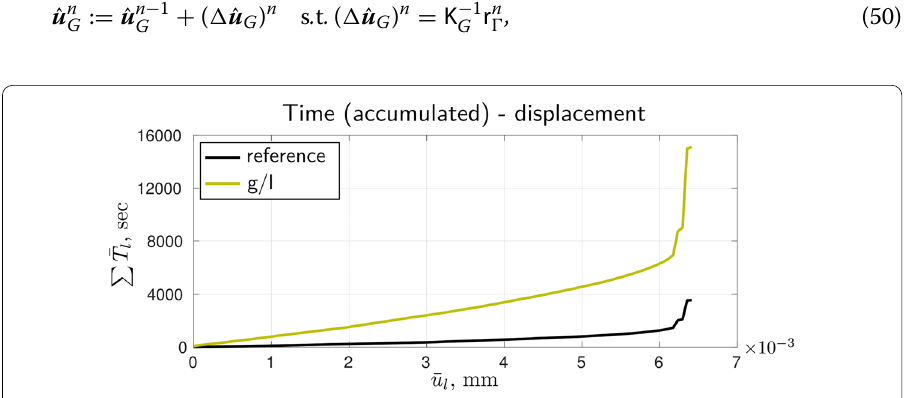
Fig. 10 Time-displacement curves in terms of ‘accumulated time’